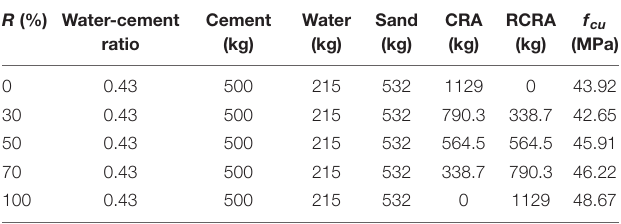
TABLE 1 | Design parameters of specimens. TABLE 2 | Mix proportions and strength of recycled aggregate concrete.